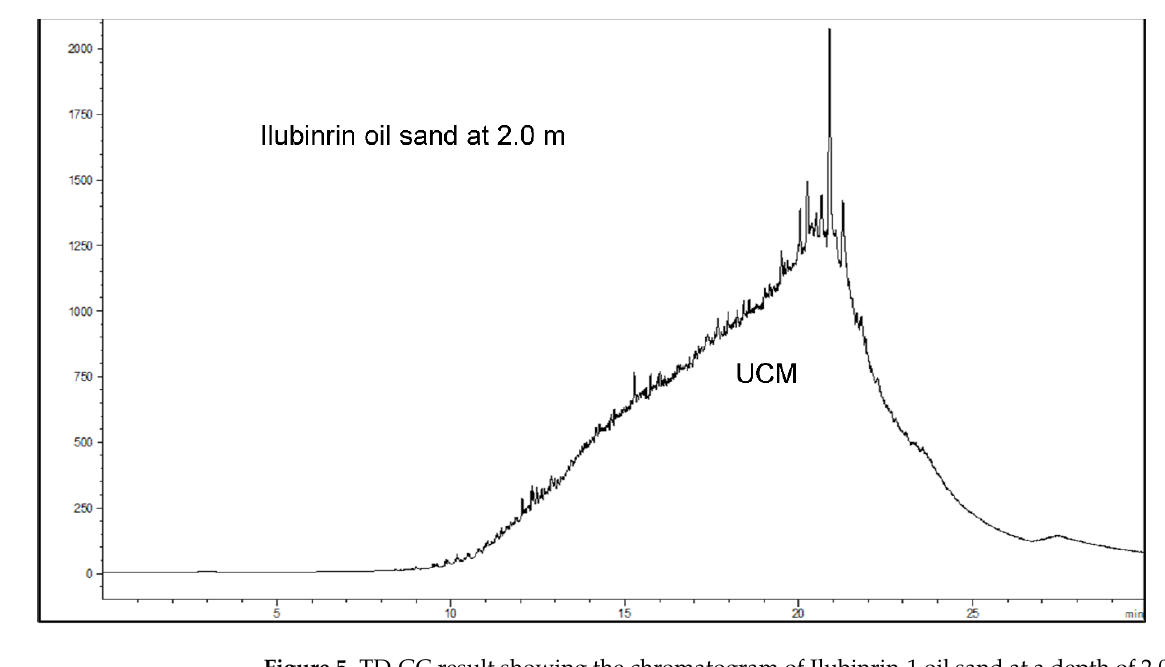
Figure 5. TD-GC result showing the chromatogram of Ilubinrin-1 oil sand at a depth of 2.0 m. The response intensity (pA) is displayed on the y -axis, while the retention time is shown on the x -axis in minutes. The chromatogram showed an unresolved complex mixture (UCM) below the peaks, indicating petroleum biodegradation.